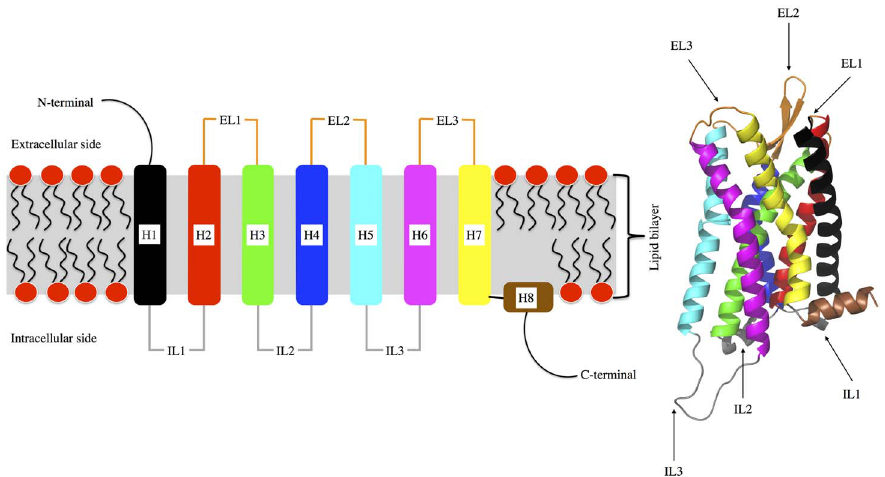
Fig. 1. Left: Schematic view of the overall structure of a G protein-coupled receptor (GPCR), with depiction of the connectivity of the intracellular (IL) and extracellular (EL) loops between helices (H). Right: 3D structure of the reconstructed m OR structure (see ‘‘Methods’’). Color codes of ILs, ELs, and Hs are identical in both left and right